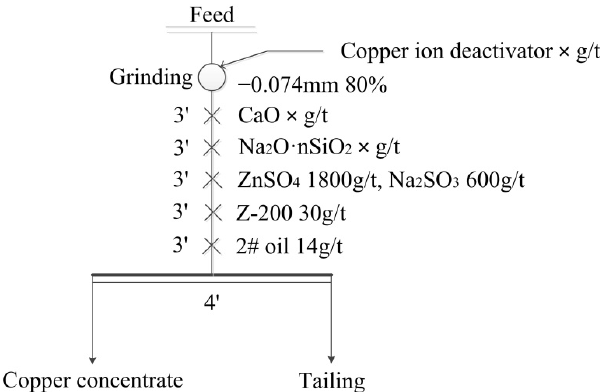
Figure 8. Experimental flow chart of the effects of copper ion deactivator, CaO and Na 2 OnSiO 2 on rough copper flotation.